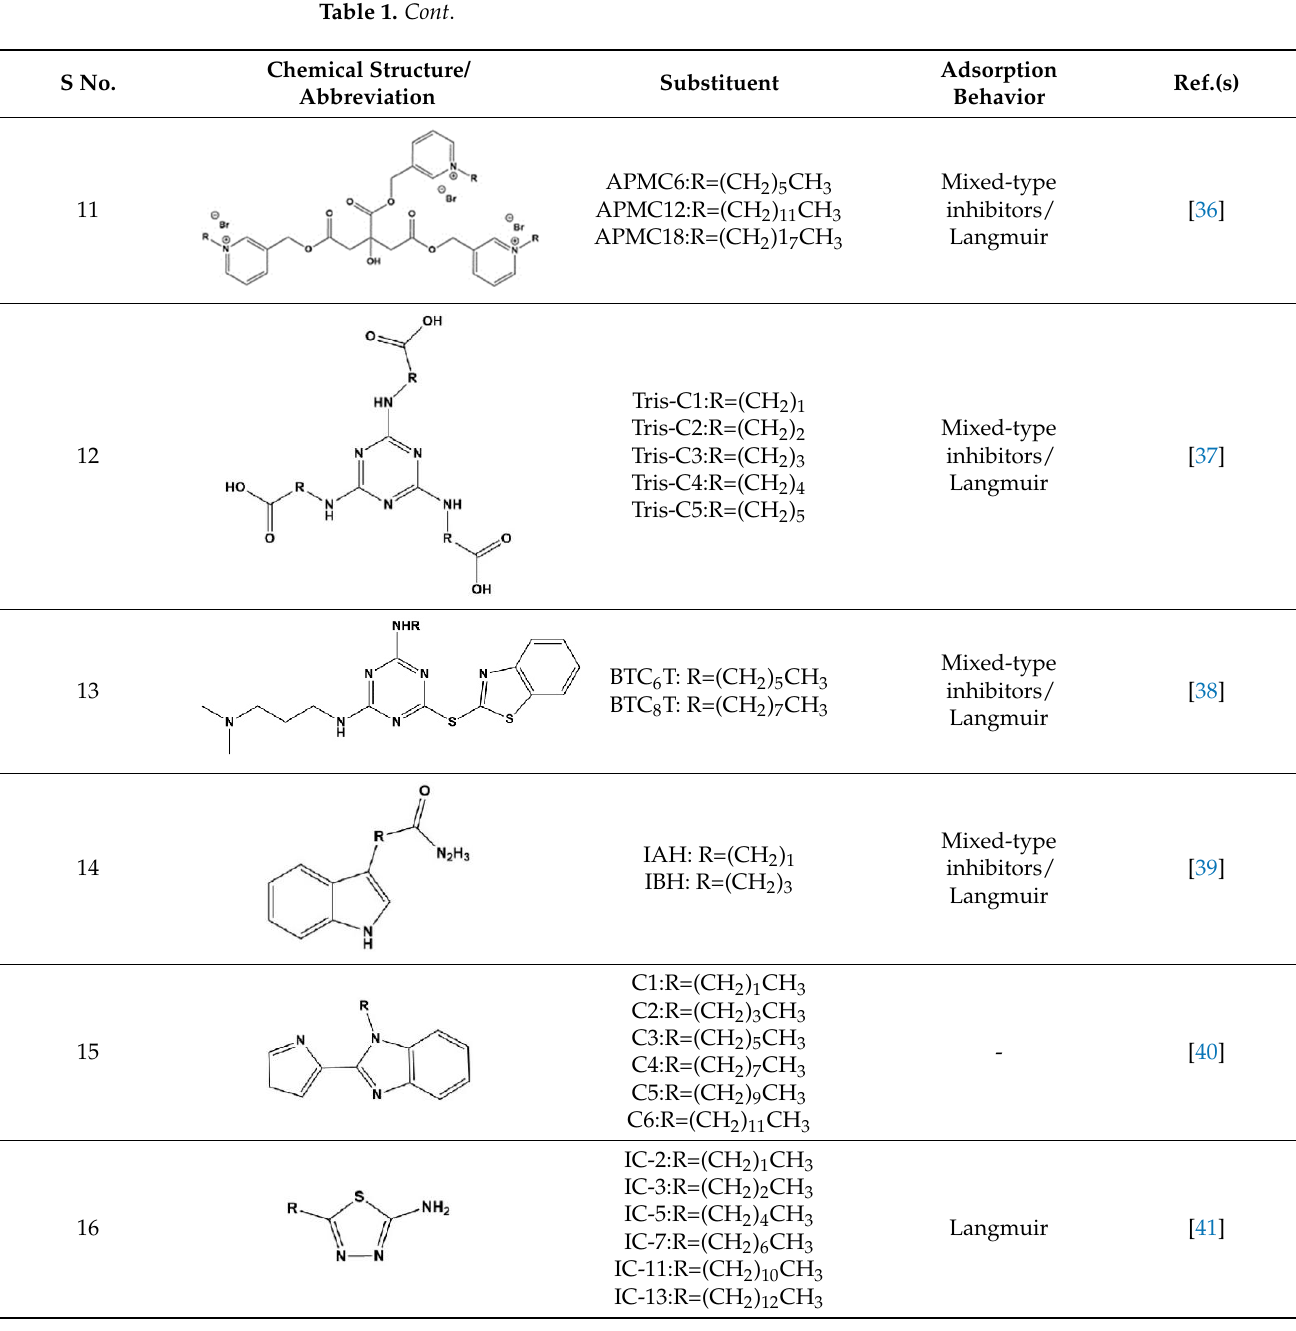
Figure 2. IBEI3 Schematic diagram on steel surface at a saturated CO 2 concentration of 3% ( m / v ) [25]. Guo and Kozaderov et al. [34] explored the corrosion inhibition behavior of triazoles with different alkyl chain lengths by the density functional theory. Electrons were distrib- uted on the triazole ring, meaning that the preferred position for the electrophilic reaction of the compound was likely to be on the ring, and the adsorption was in a planar config- uration. The absolute value of adsorption energy increased with the increase in alkyl chains, and the corresponding inhibition efficiency also followed the same law. Koza- derov [33] concluded that the longer the length of the triazole alkyl chain, the greater their inhibition effect for a copper corrosion system in a medium of sodium chloride with a multi-component passivation film formed on brass, including ZnO·xH 2 O, Cu 2 O and CuO oxides and a small number of soluble complexes of zinc and copper with the studied in- hibitor molecules. Yoo et al. [37] synthesized a series of tris(carboxy alkylamino)triazines with varying lengths of the alkyl chain and found that they were mixed adsorption corro- sion inhibitors that demonstrated a corrosion inhibition efficiency value that increased strongly with an increasing alkyl chain length. Hu et al. [38] synthesized BTC 6 T and BTC 8 T